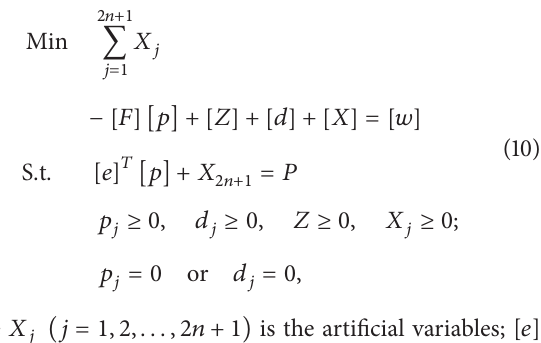
Equations (8) and (9) represent a constrained nonlinear programming problem, which is solved by the modified simplex method.